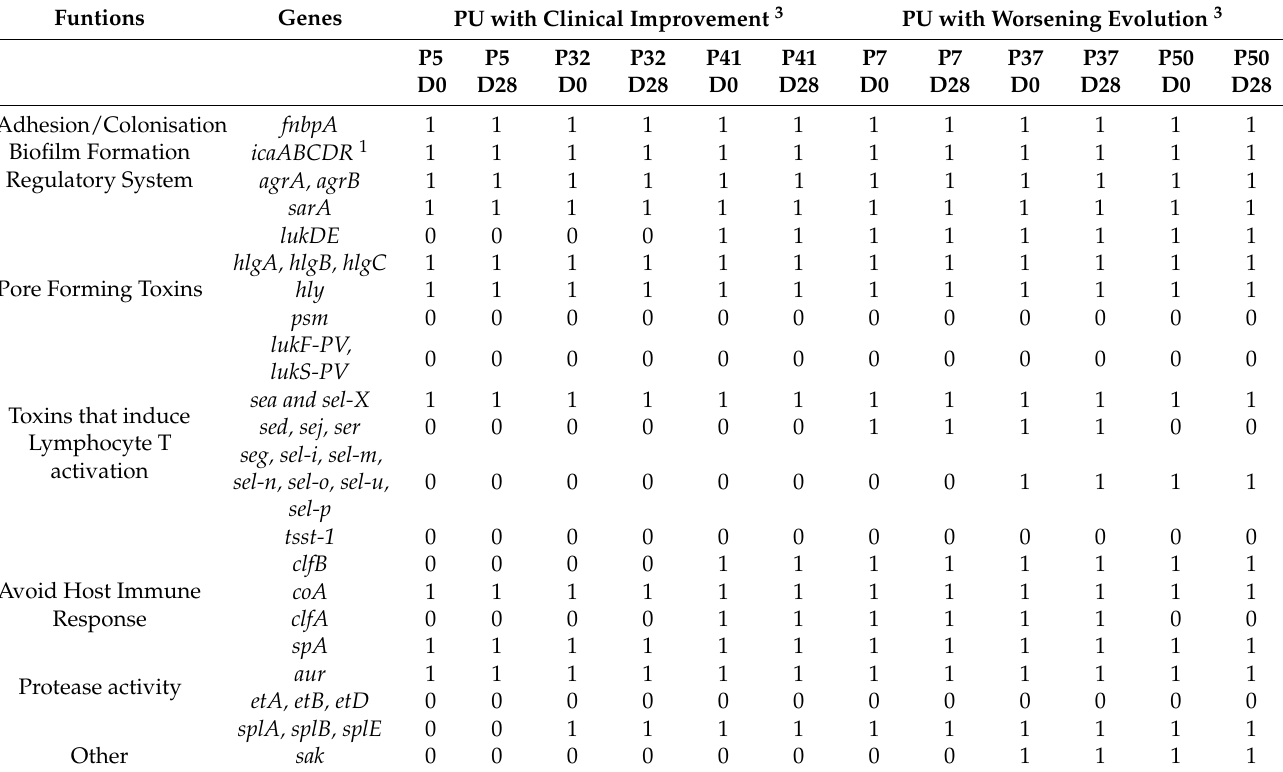
Table 3. Main virulome and resistome traits of S. aureus strains isolated from pressure ulcers at inclusion (D0) and day 28